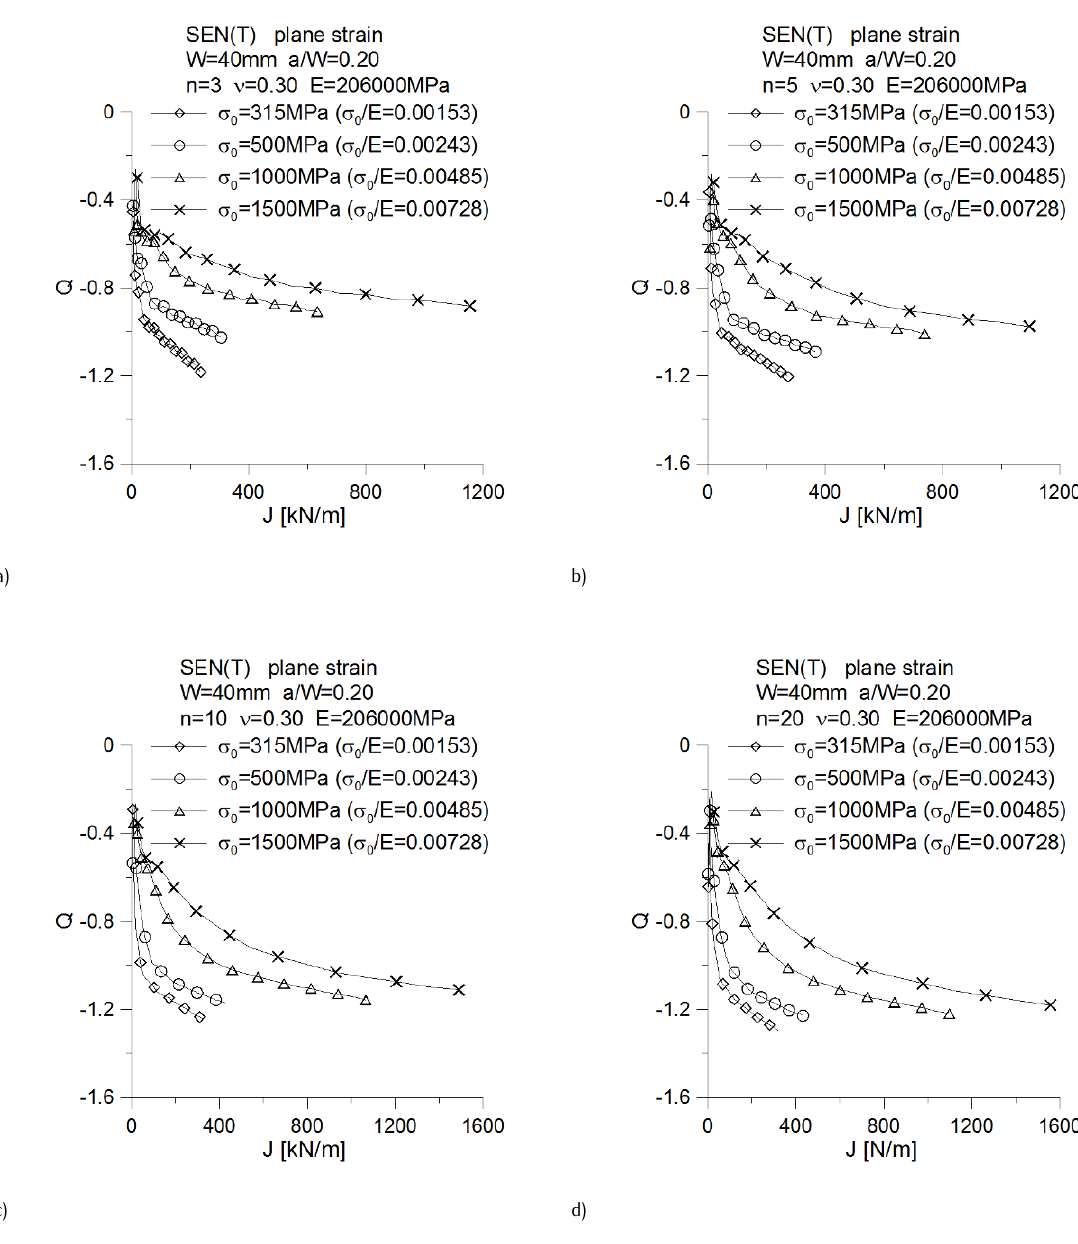
Figure 22. The influence of the yield stress on J - Q trajectories for SEN(T) specimens with crack length a / W =0.20 for different power exponents n in R-O relationship: a) n =3; b) n =5; c) n =10; d) n